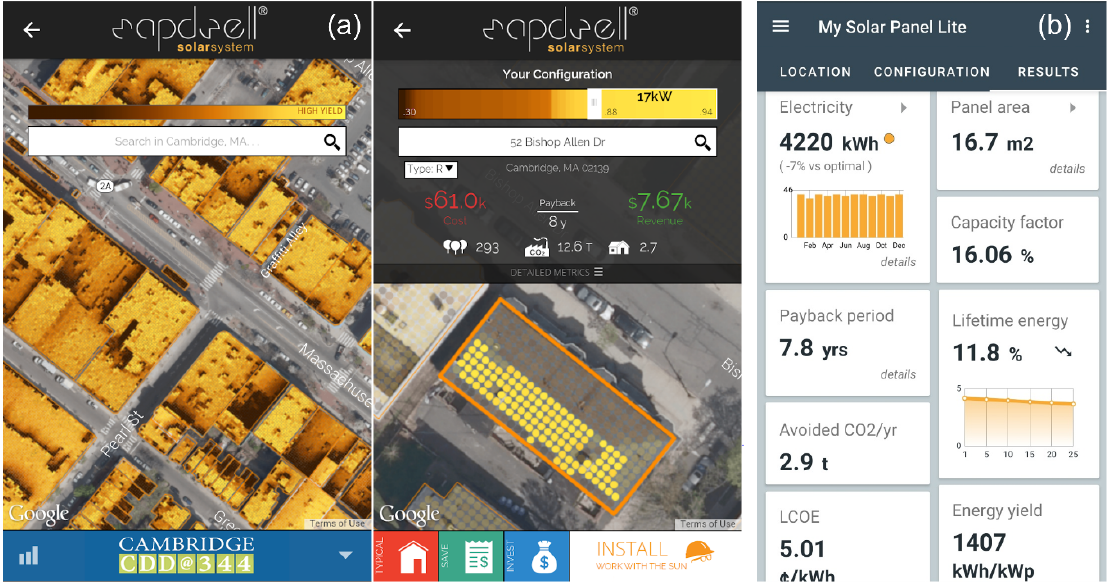
Figure 5. Representative smartphone applications for assessment of environmental benefits and economic profit. ( a ) Mapdwell Solar System app [88], ( b ) My Solar Panel Lite app.